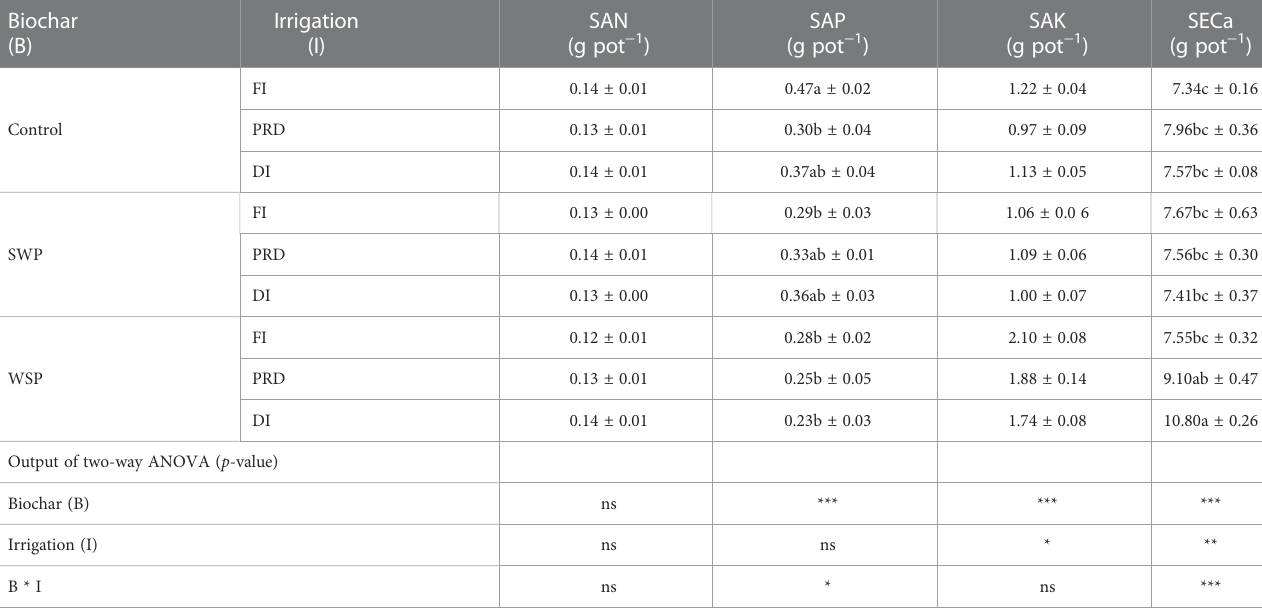
TABLE 4 The effects of treatments and output of two-way ANOVA for soil available N (SAN), soil available P (SAP), soil available K (SAK), and soil exchange Ca (SECa) content. Biochar